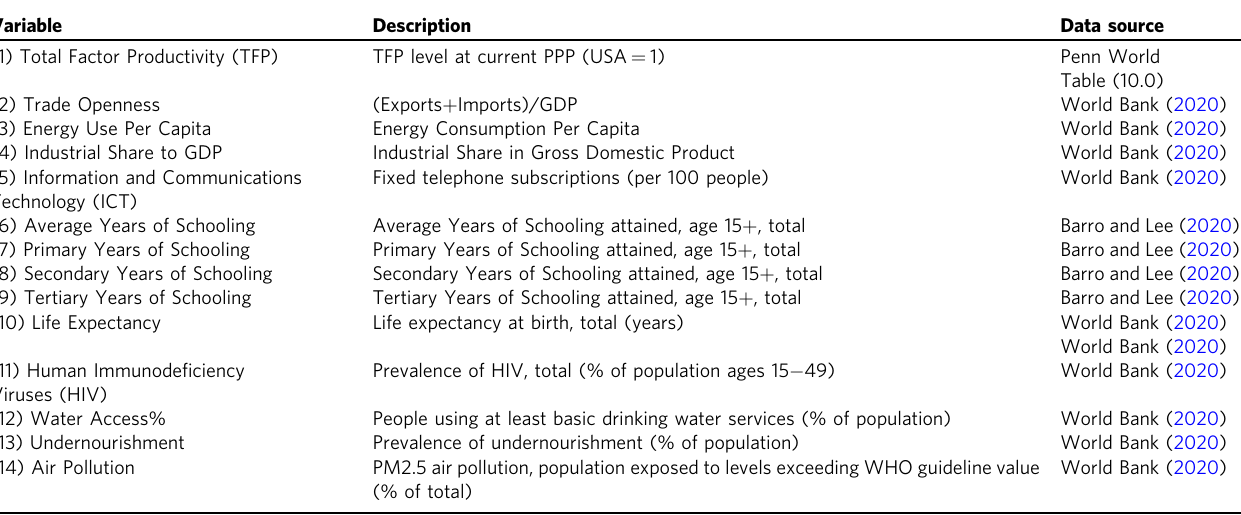
Table 1 Variables notations, de fi nitions and